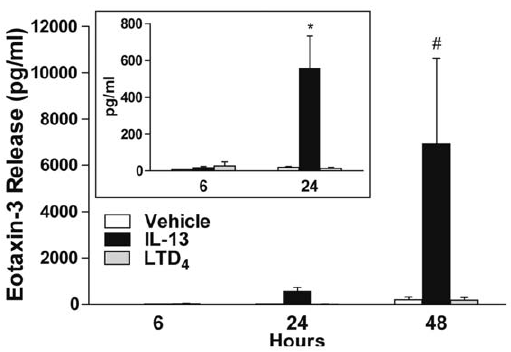
Figure 2. Kinetic of eotaxin-3 release from airway epithelial cells. Airway epithelial cells were incubated with vehicle (open bars), 10 ng/ml IL-13 (closed bars), or 100 nM LTD 4 (gray bars) for different times. Incubations were stopped by removing the supernatants and eotaxin-3 was quantified as described in Material and Methods . The data represent the mean ( 6 SEM) of four independent experiments. Insert represents a zoom of the 6 and 24 hours data points. * p=0.002 vs 6 hours, # p=0.003 vs 24